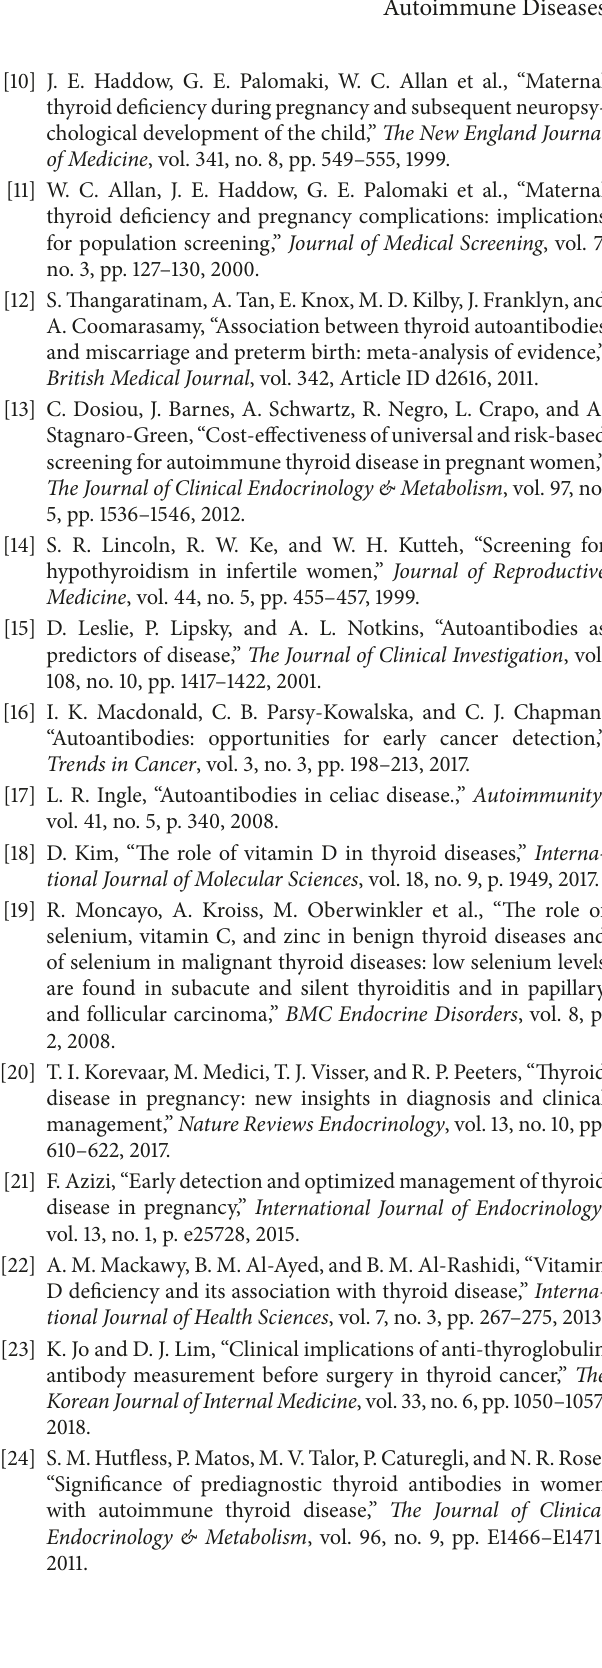
Table S1: physician reported ICD-10-CM codes dis- tribution for hypothyroid and hyperthyroid